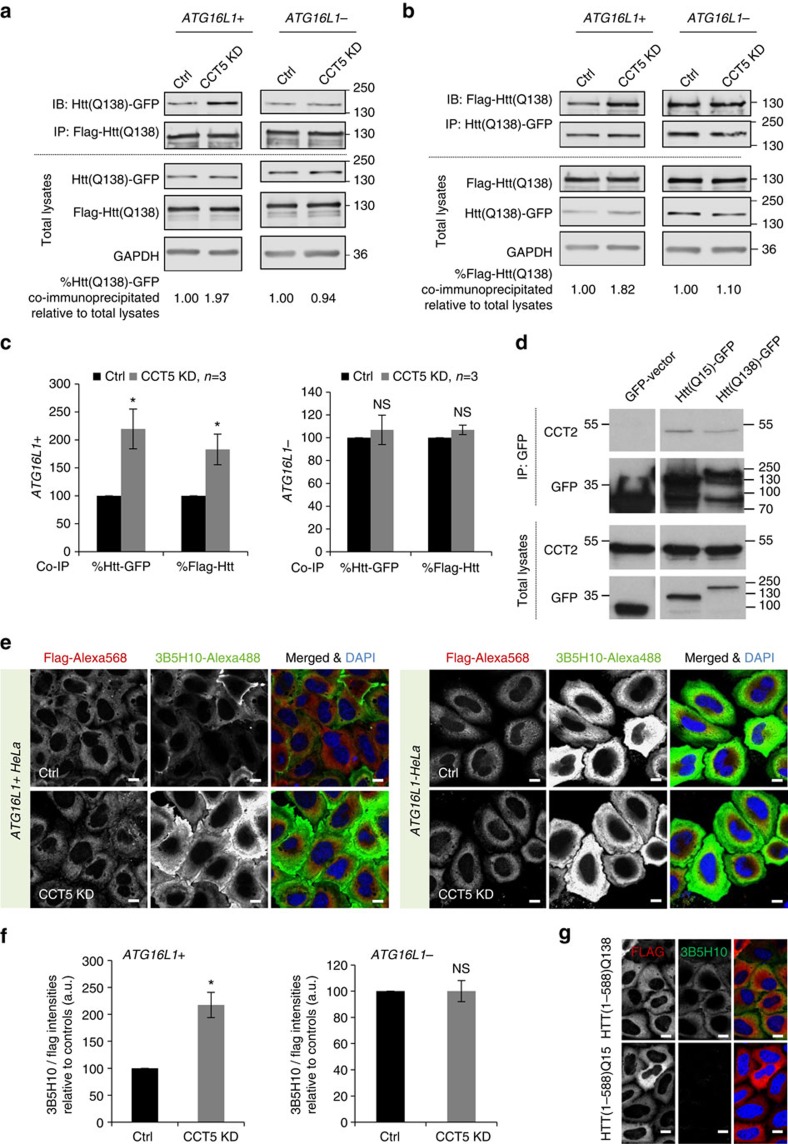
CCT depletion increases PolyQ oligomerization consequently to reduced autophagic clearance.(a,b) Oligomerization of mutant htt in CCT5-depleted Hela cells, both ATG16L1+ and ATG16L1−. CCT5 depletion enhanced the amount of coimunoprecipitation of GFP-tagged mutant HTT(1–548) with Flag-tagged mutant HTT(1–588) —see left a and vice-versa—see right b, in autophagy competent HeLa cells, but failed to do so in the autophagy incompetent cells: ATG16L1− HeLa. (c) Quantification of mutant htt co-immunoprecipitation relative to total lysates/input from three independent experiments. The control condition was set to 100 and the bars represent the mean±s.d. (n=3; *P<0.05, NS, not significant; two-tailed sample t-test). See Methods. (d) CCT co-immunoprecipitation with the Htt(1–548)Q15 and Htt(1–548)Q138 constructs tagged with GFP at the C terminus. HeLa cells were transfected with GFP-vector, Htt(1–548)Q15 –GFP or Htt(1–548)Q138-GFP for 48 h and the GFP-tagged proteins were pulled-down using the GFP-Trap technology. (e) 3B5H10 staining in CCT5-depleted HeLa cells, both ATG16L1+ and ATG16L1−. Scale bar throughout the panel is 10 μm. See Methods. (f) Quantification of 3B5H10 to Flag ratio signal intensities from three independent experiments. The bars represent the mean±s.d. (n=3; *P<0.05, NS, not significant; two-tailed sample t-test). (g) 3B5H10 antibody preferentially label cells overexpressing the pathogenic polyQ expansions in Htt(1–588). HeLa cells were transiently transfected with either Flag-tagged HTT(1–588)Q138 or Flag-tagged HTT(1–588)Q15 and immunostained with 3B5H10 antibody. Scale bar throughout the panel is 10 μm.